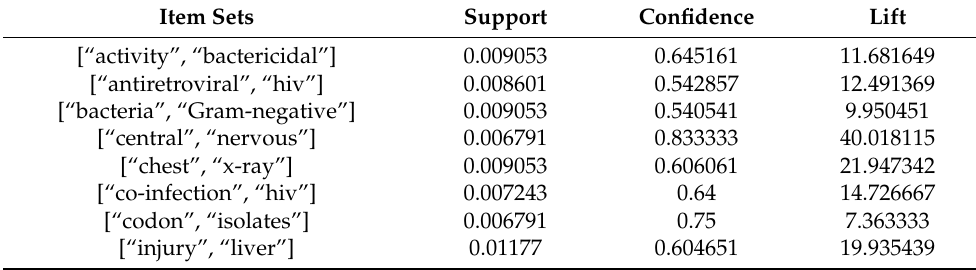
Table 8. Sample item sets of rifampicin